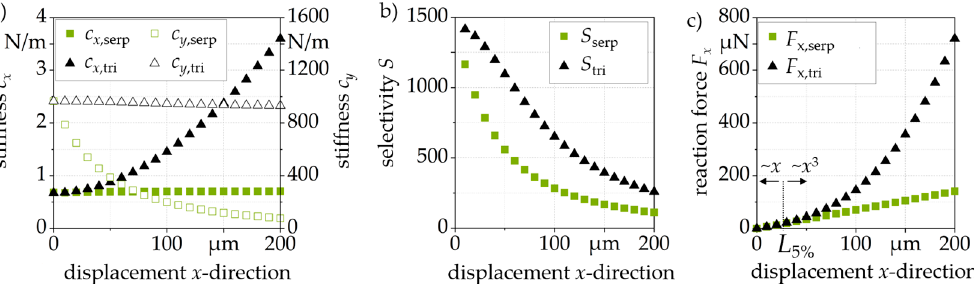
Figure 3. Comparison of the triangular and serpentine springs: ( a ) stiffness, ( b ) selectivity (COMSOL Multiphysics solid-state simulation results), ( c ) spring reaction force F x ,serp and F x ,tri .